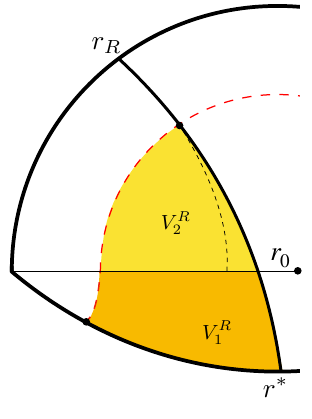
Figure 9. A corner of the right defect patch illustrating the relevant volumes in the evaluation of the subregion CV proposal. The red dashed curve indicates the cuto(cid:11) surface and the volumes V R in eq. (4.12) and V R in eq. (4.15) are colored in dark and light yellow respectively. The dashed 1 2 black line indicates the division between the two integration regions in eq.